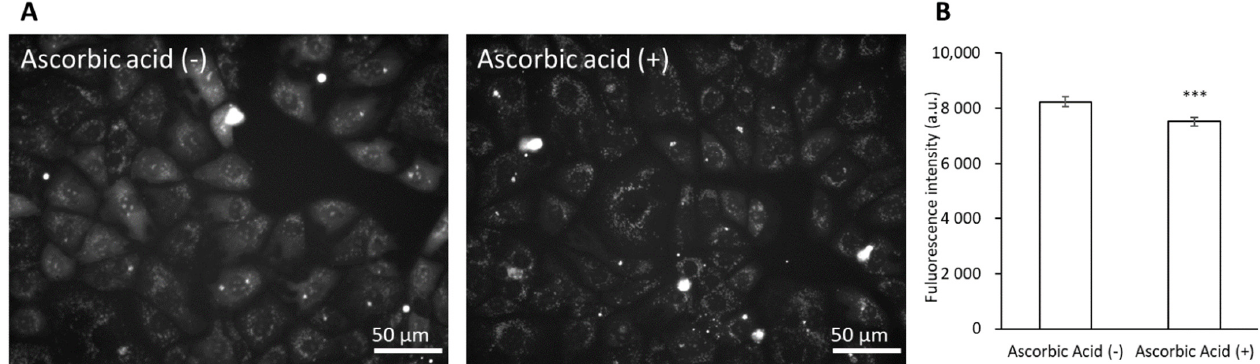
Figure 6. The fluorescence intensity of MitoSOX. The cells were incubated in a medium containing 25 µ M dabigatran etexilate with or without 500 µ M ascorbic acid. The cells were incubated for 6 h, the supernatant was aspirated, and MitoSOX was added. The fluorescence intensity of MitoSOX was measured using fluorescence microscopy. ( A ) Fluorescent microscopy utilized to assess cellular uptake of MitoSOX. ( B ) Data are expressed as means ± SD (n = 20). The sample size is the number of cells in the analyzed images. Ex = 535–555 nm and Em = 570–625 nm. *** p < 0.001.